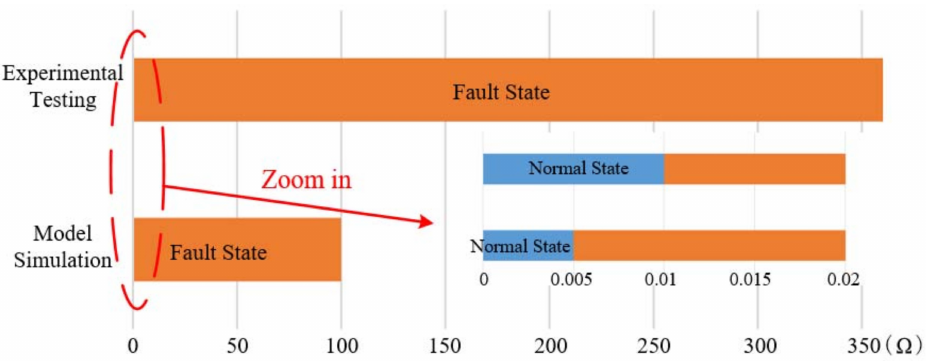
Figure 3. The normal and fault values of the connection resistance of connectors in the experimental testing and model